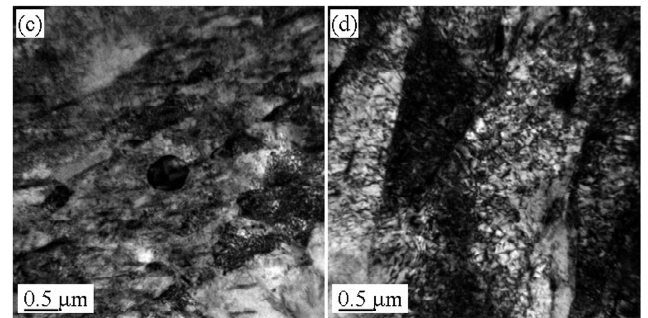
Figure 4. Microstructure of tempered 5140 steel tempered at 480 °C before and after different accumulated proton irradiation observed by TEM pictures of ( a ) 0 protons/cm 2 , ( b ) 2 × 10 14 protons/cm 2 , ( c ) 2 × 10 15 protons/cm, ( d ) 2 × 10 16 protons/cm 2 .